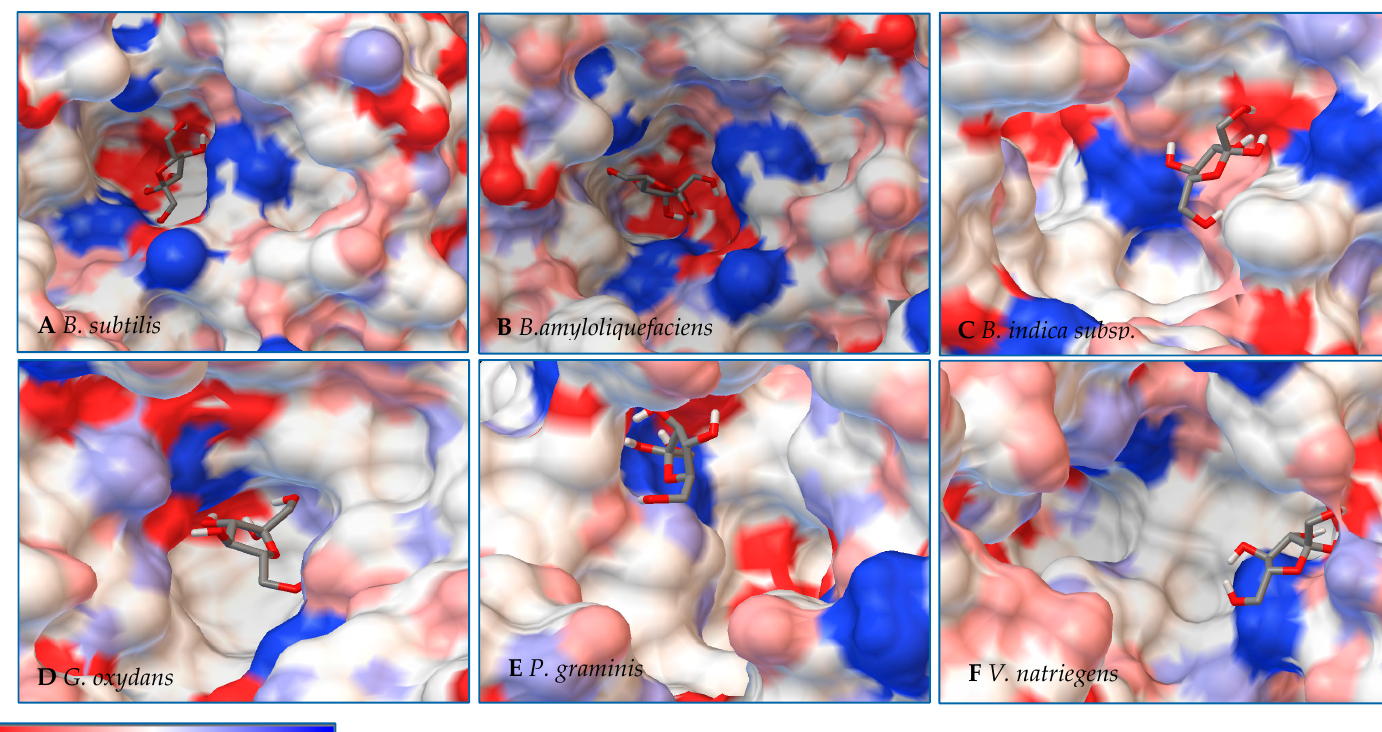
Figure 9. Models of LS from ( A ) B. subtilis, ( B ) B. amyloliquefaciens, ( C ) B. indica subsp. indica, ( D ) G. oxydans, ( E ) P. graminis , and ( F ) V. natriegens with fructose docked within the active site. Fructose is docked in a position representing the least binding energy state. Coloring represents the electrostatic surface potential (K b T / e c ) with a spectrum of red (electronegative) to blue (electropositive). The surface charge was calculated using AutoDock v 4.2 and the PDBqt file was uploaded to OPAL webserver for PQR map and visualization was done using PyMol APBS plugin.